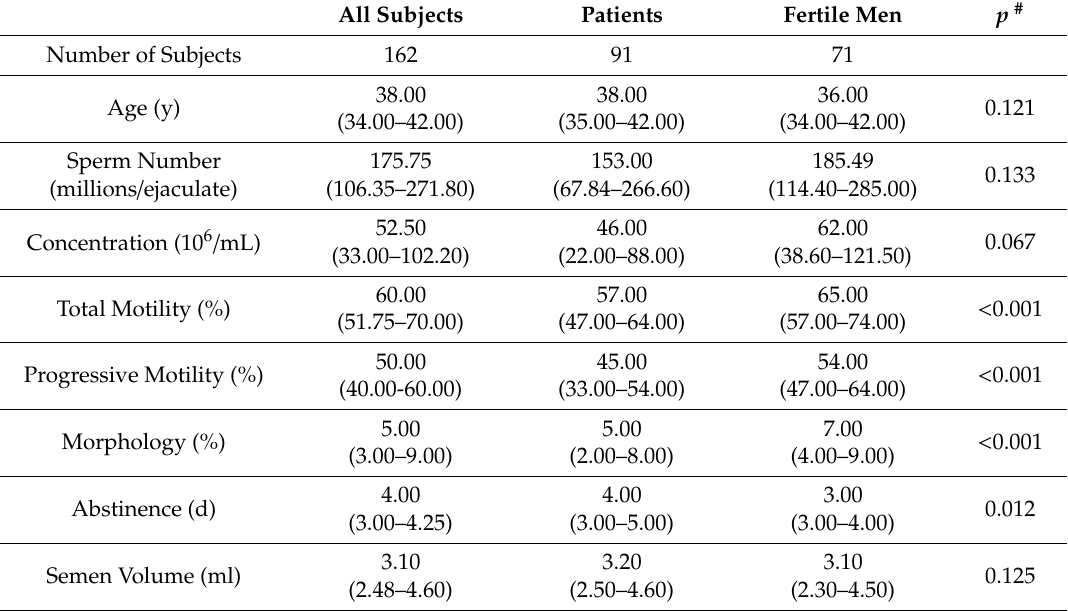
Table 1. Age and semen parameters in fertile men and patients. Data are expressed as median (interquartile). All